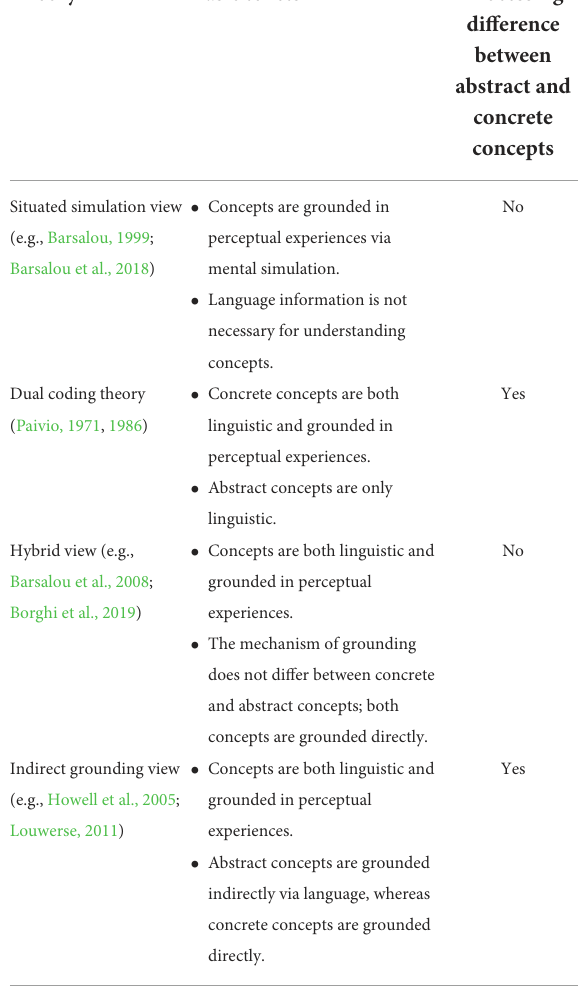
TABLE 1 Summary of conceptual representation theories.